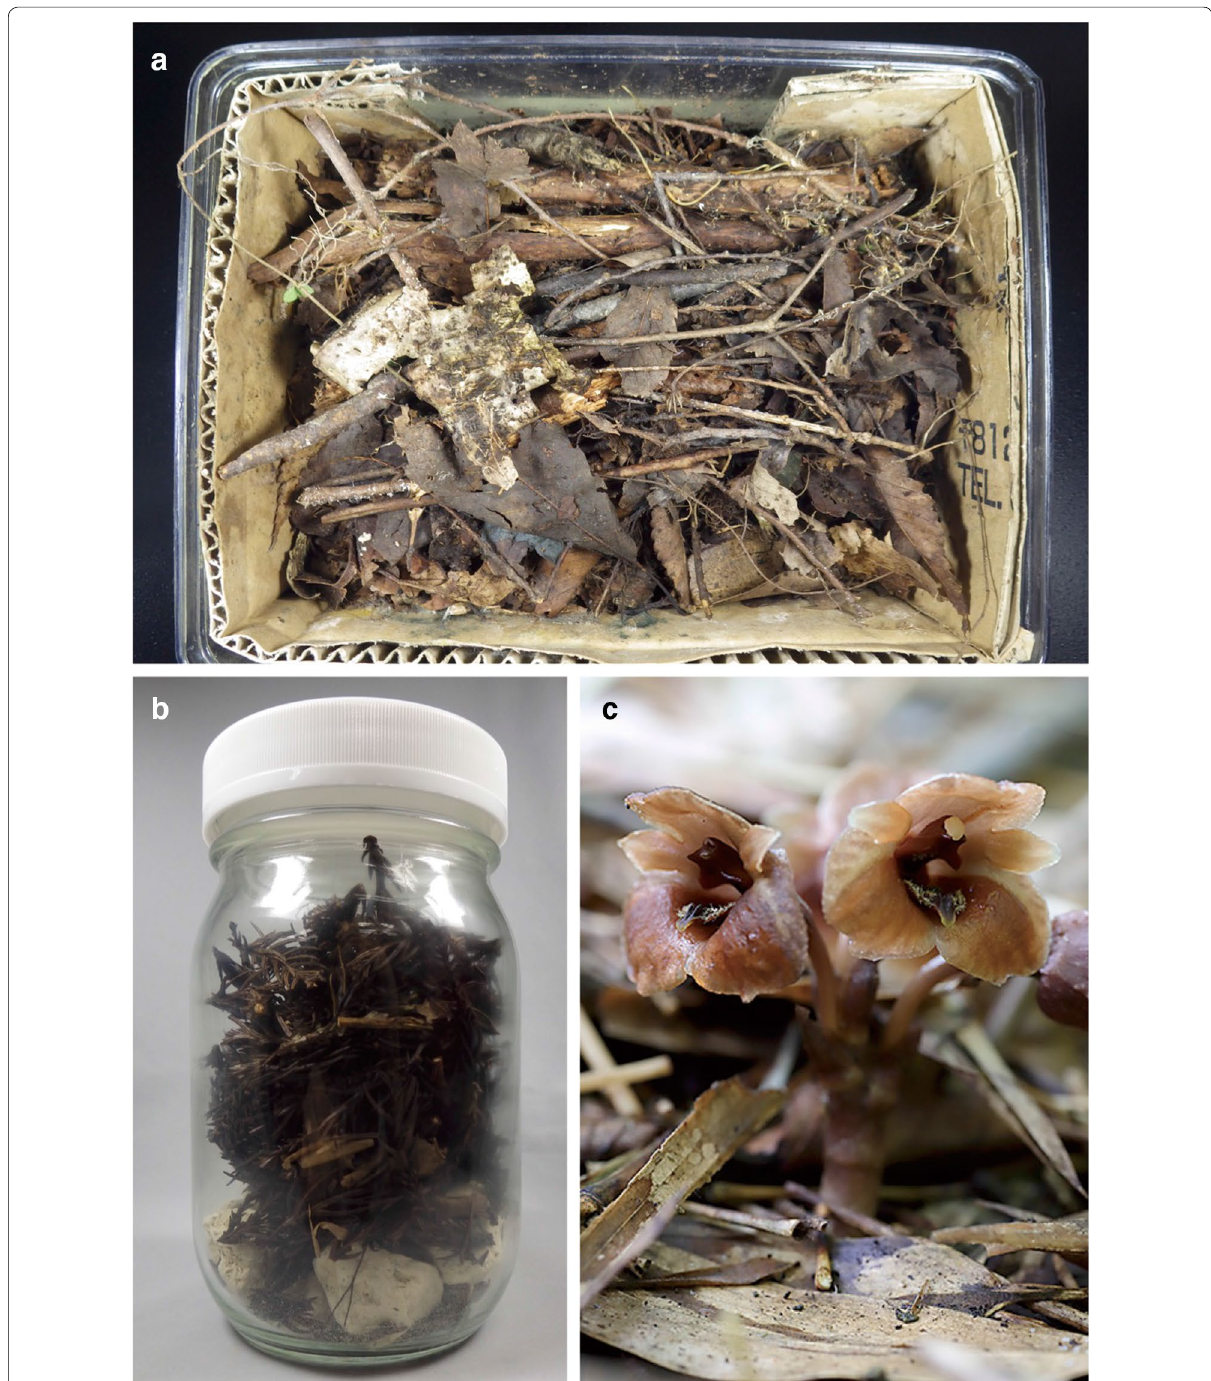
Fig. 1 The culture vessels used in this study and flower morphology of Gastrodia pubilabiata . Plastic boxes ( a ) and glass bottles ( b ) were filled with leaf litter collected from the natural habitat. c A flowering plant in its habitat (photo by T.